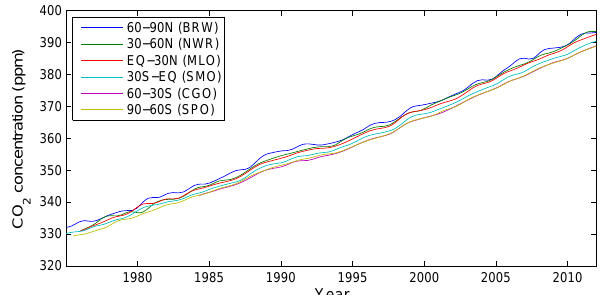
Figure 3. Reference weekly CO 2 mole fraction measurements (ppm) covering various time spans for 30 ◦ latitude bands used to impute missing data points. BRW, NWR, MLO, SMO, CGO, and SPO are codes to denote Barrow (71.3 ◦ N, 156.6 ◦ W), Niwot Ridge (40.0 ◦ N, 105.6 ◦ W), Mauna Loa (19.5 ◦ N, 155.6 ◦ W), American Samoa (14.2 ◦ S, 170.5 ◦ W), Cape Grim (40.7 ◦ S, 144.7 ◦ E), and South Pole (89.9 ◦ S, 24.8 ◦ W).